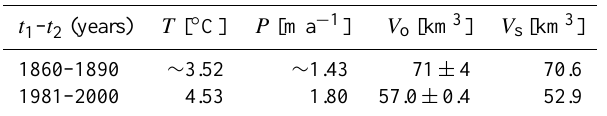
Table 4. Mean annual temperature ( T ) at Hólar in Hornafjörður and precipitation ( P ) at Fagurhólsmýri, averaged over the years from t 1 to t 2 . V o is the volume at the year t 2 , from Table 3. V s is the volume of a stable spin-up glacier corresponding to the average climate over the years t 1 – t 2 .